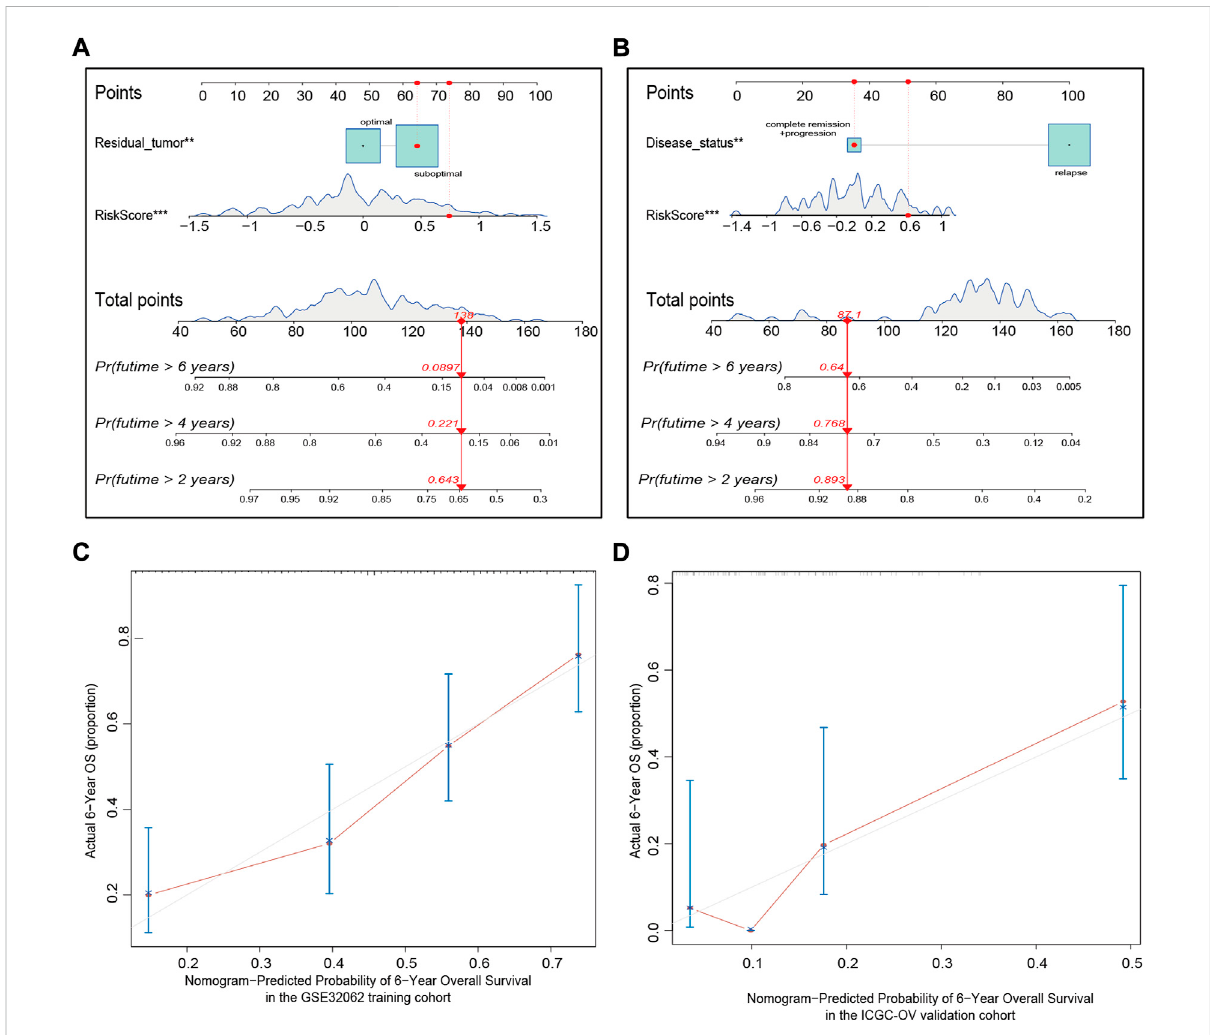
FIGURE 7 Nomogram establishment for predicting the 2-, 4-, and 6-year OS of OV patients in the GSE32062 (A) and ICGC (B) cohorts. An example demonstrating the percentage of survival according to the nomogram score is marked in red. To use the nomogram, fi rst fi nd the position of a variable on the variable axis, and then, draw a vertical line upward to fi nd the point number of the variable. The sum of these point numbers is presented on the total points axis, and a vertical line is drawn downward to determine the differential OS probabilities. ** p < 0.01; *** p < 0.001. Calibration curves of the nomogram predictive performance in the GSE32062 (C) and ICGC (D) cohorts. Distributions of the predicted probabilities of 6-year OS are shown at the top of the graphs, the brownish red solid line indicates the performance of the nomogram; the closer the line to the gray line, the better the consistency between predicted and actual outcomes. OS, overall survival; OV, ovarian cancer; ICGC, International Cancer Genome